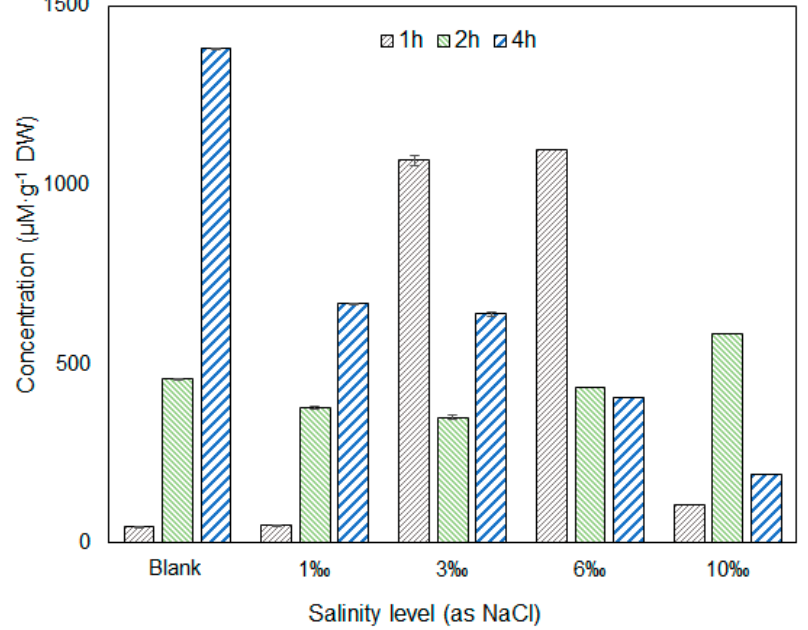
Figure 2. Variation of the TotAA with salinity levels. Gray bars represent the concentration of TotAA at one-hour experimental endpoint, green and blue bars represent the concentration at the end of two and four hours. Data presented are the average of two replicates and error bars represent standard deviations of the combined data.